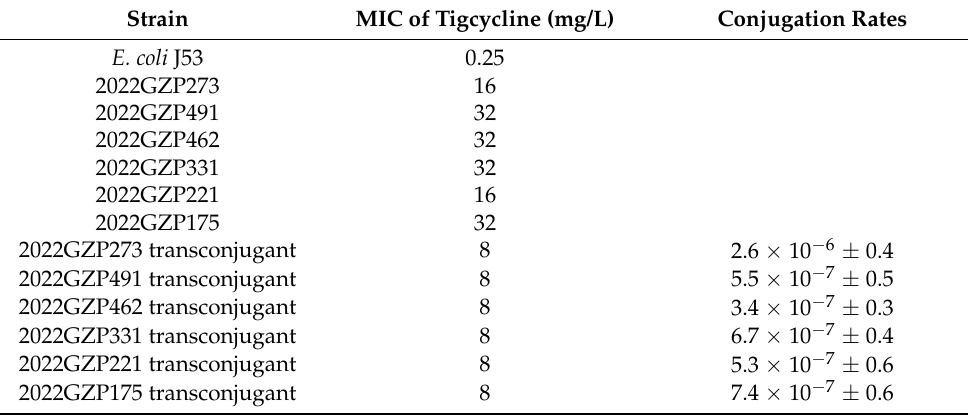
Table 2. MICs of E. fergusonii strains, E. coli J53 and selected transconjugants.